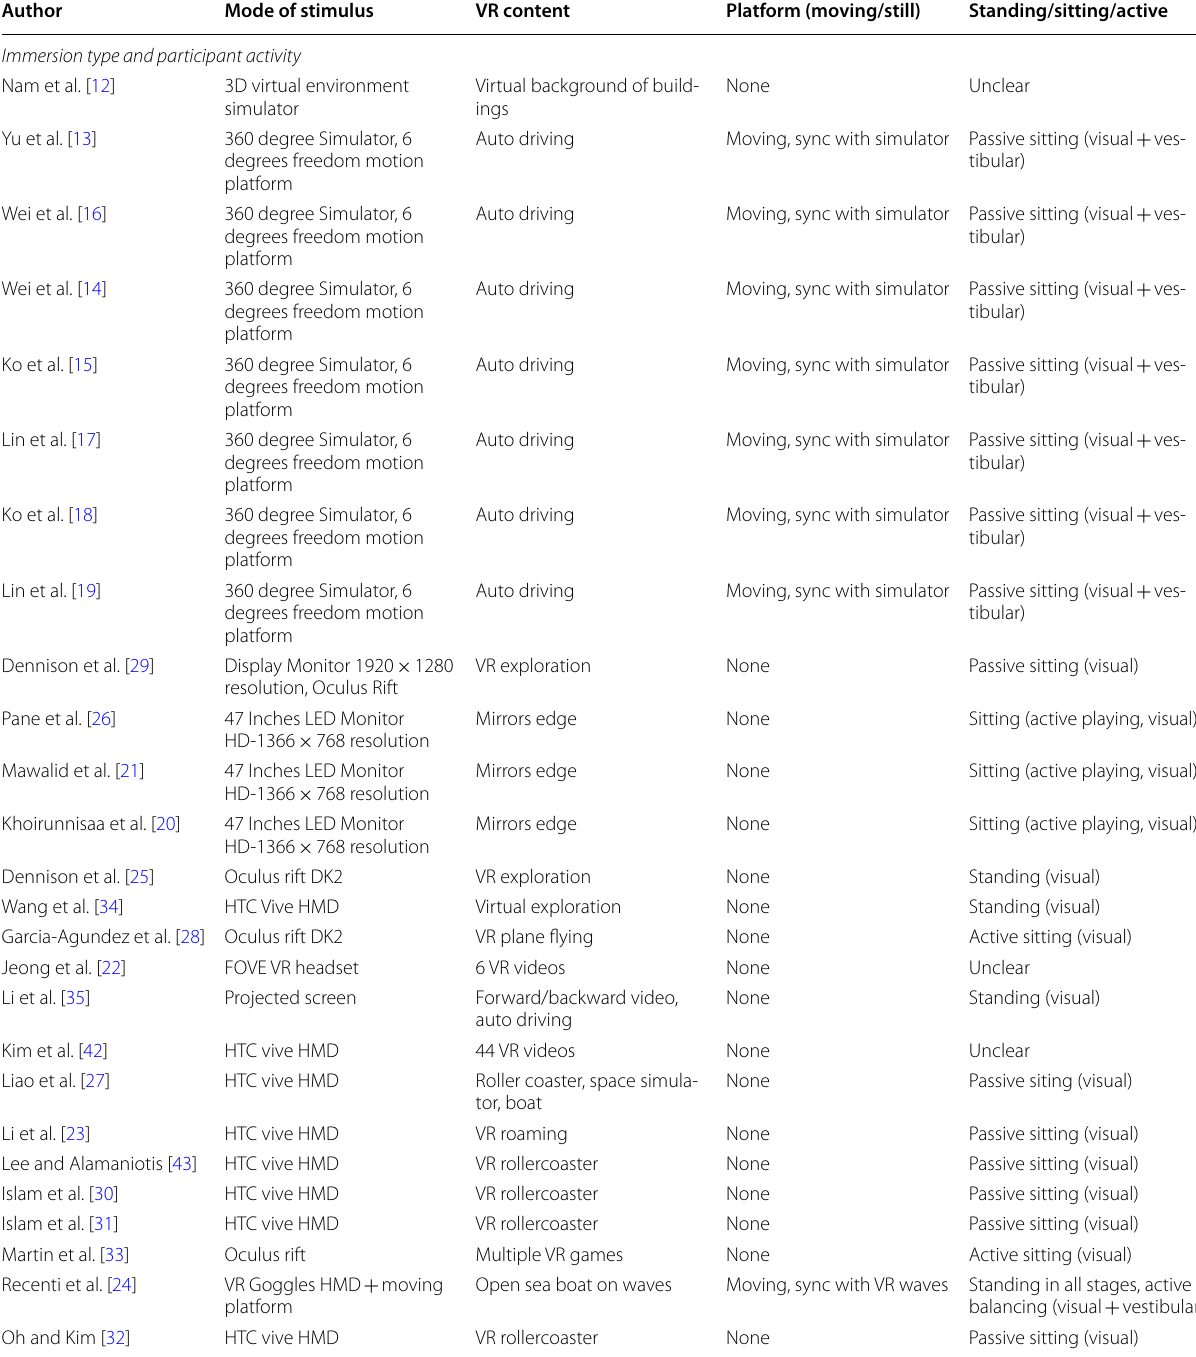
Table 4 Immersion type including mode of stimulus, VR content, platform usage, and participant